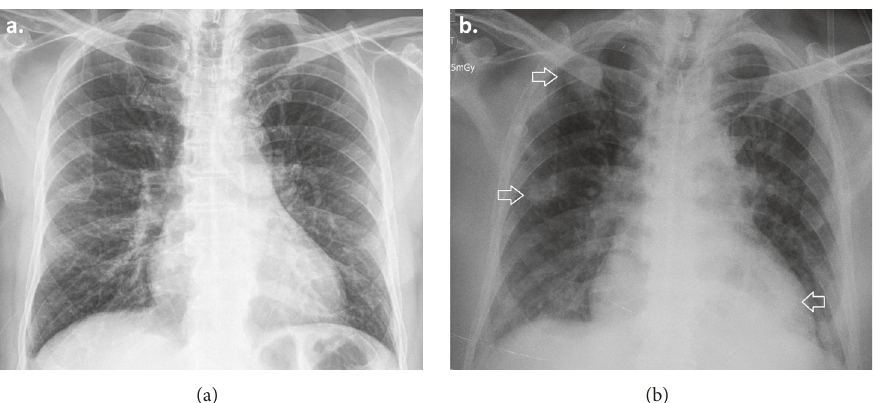
Figure 1: Chest X-ray. (a) Thickening of bronchial walls with no concomitant parenchymal abnormalities. (b) Multiple ill-defined lung nodules (arrows). Enlargement of the cardiac silhouette and left pleural fluid.